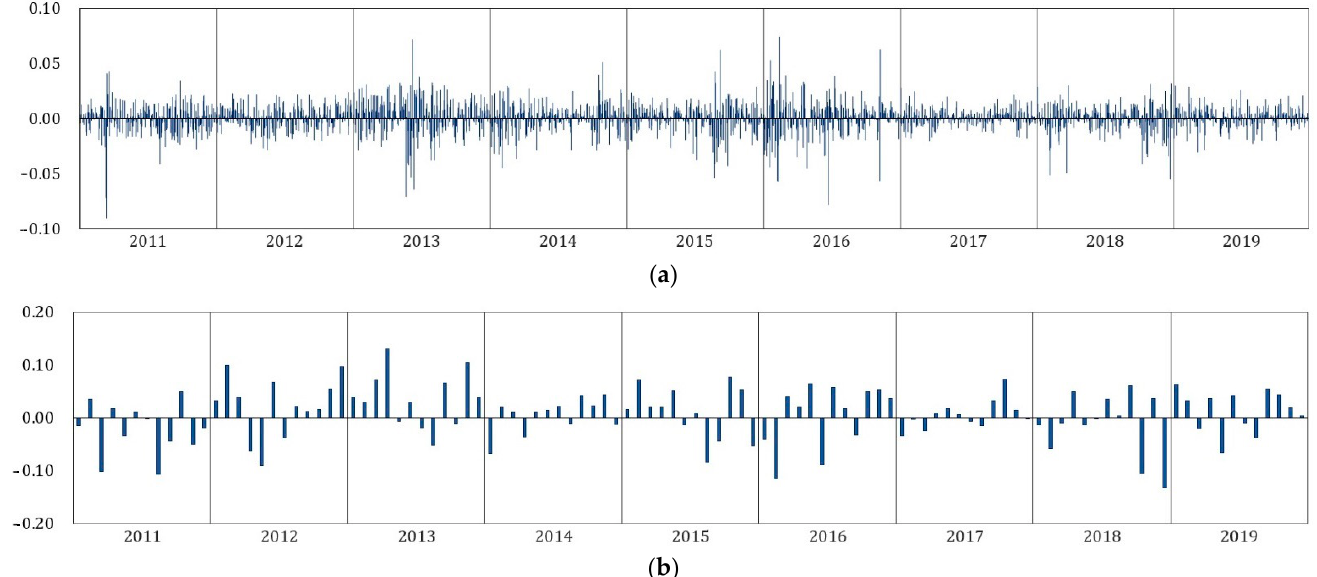
Figure 2. ( a ). Time Plot of the Daily Log Returns of Nikkei 225 Futures. ( b ). Time Plot of the Monthly Log Returns of Nikkei 225 Futures.